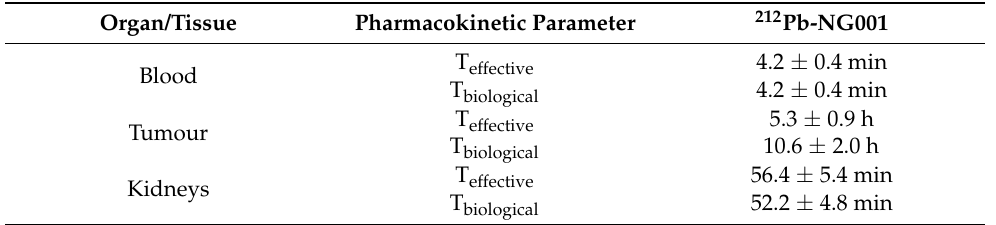
Table 1. Biological and effective half-lives (T) of 212 Pb-NG001 in selected organs/tissues in nude mice with C4-2 xenografts, N = 3–11.